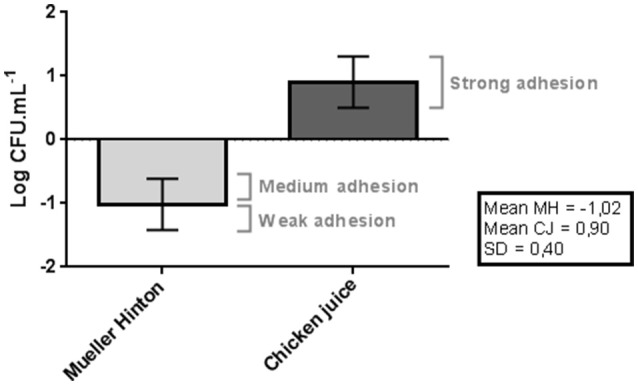
Difference between adhesion and the mean of initial inoculum obtained in the counts (log of CFU/mL) of C. jejuni in the Mueller Hinton and Chicken juice. Error bars indicate the standard deviation for the means of the counts obtained for each strain at three repetitions. SD indicates the standard deviation used in the classification of the strains: Poor adherence (counts below the mean in MH up to 1 SD), Average adherence (higher than average counts in MH up to 1 SD), Strong adherence (higher than average counts in MH Up to more than 1 SD).